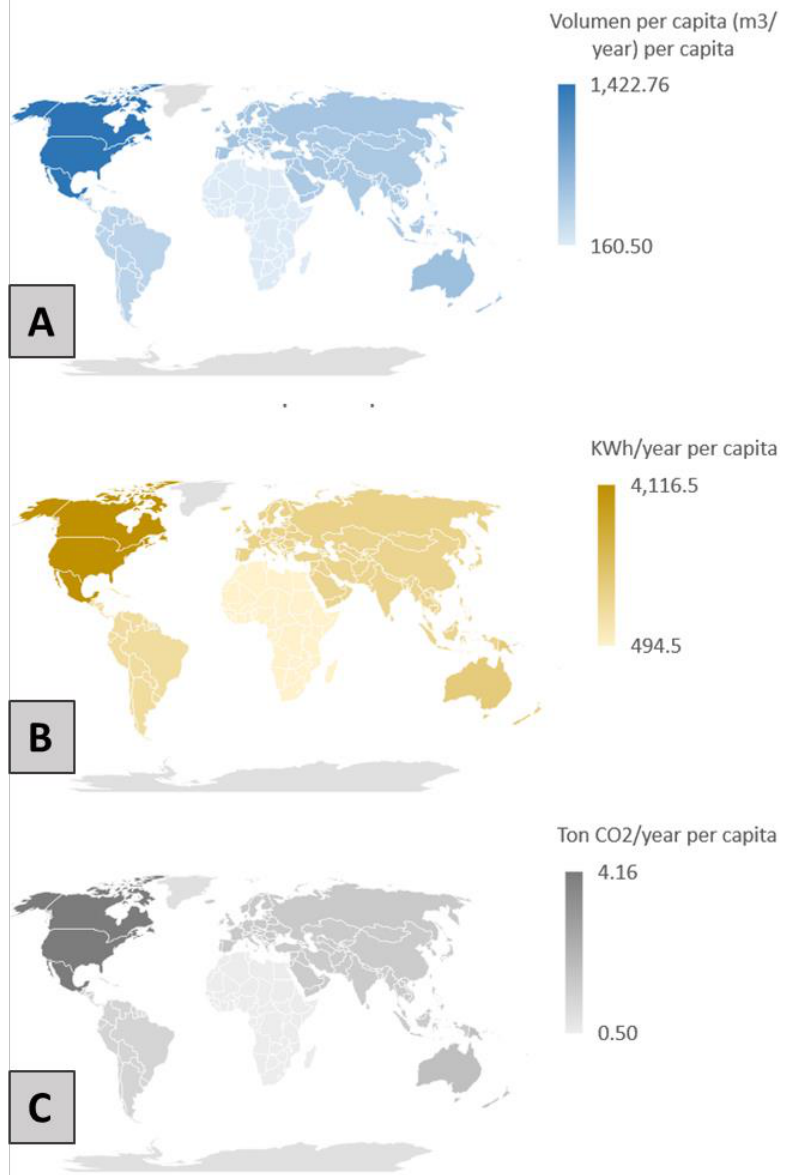
Figure 4. Analysis per capita of indicators related to water usage. ( A ) Total water withdrawals (km 3 /year), ( B ) energy requirements (kW/year) and ( C ) GHG emission (t CO 2 e/year).